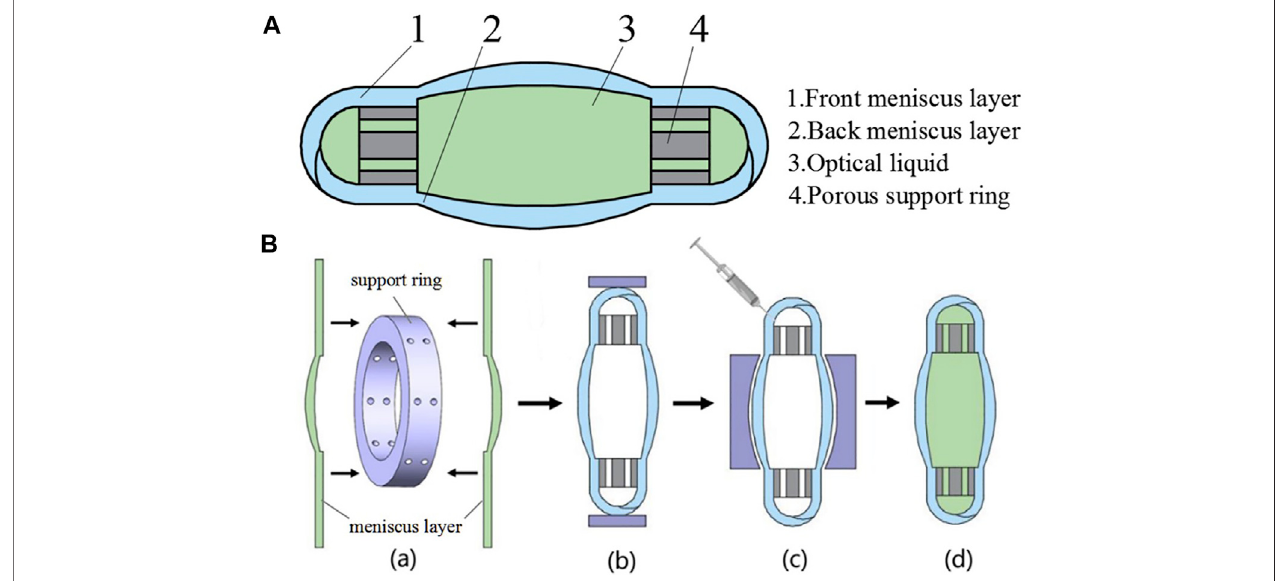
FIGURE 2 | (A) The structure diagram of IOL. (B) The assembling process of the designed IOL from Liang et al. (2019), with the permission of